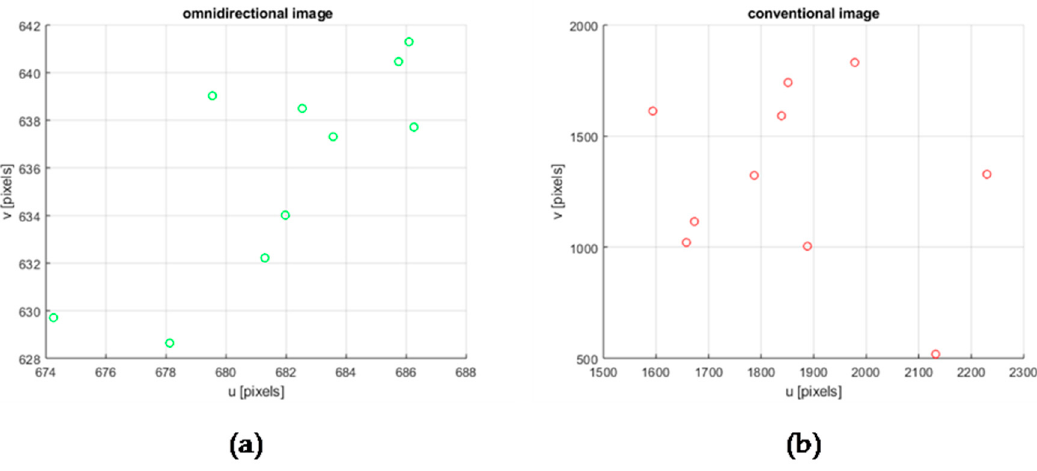
Figure 11. Sample omnidirectional ( a ) and perspective ( b ) images captured in the simulated environment.